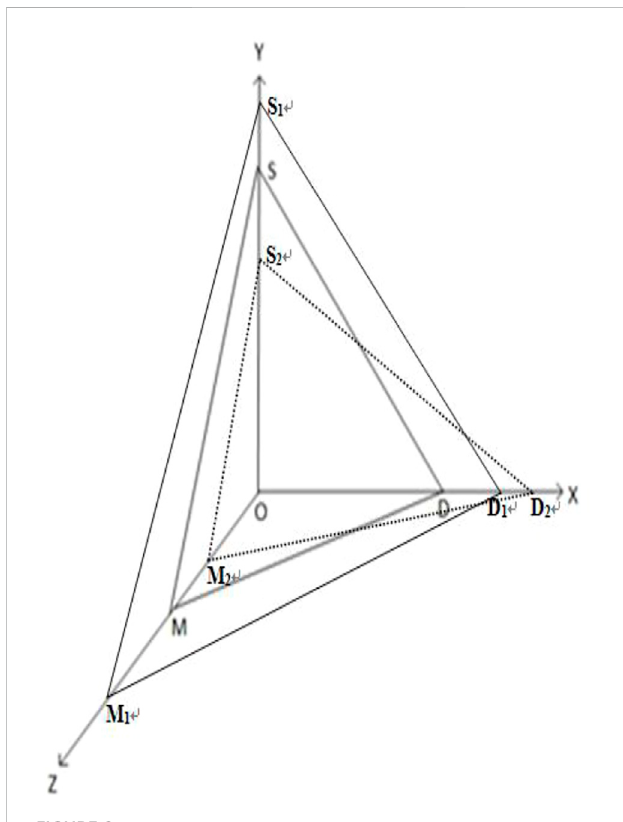
FIGURE 2 Schematic diagram of urban comprehensive resilience index polyhedron